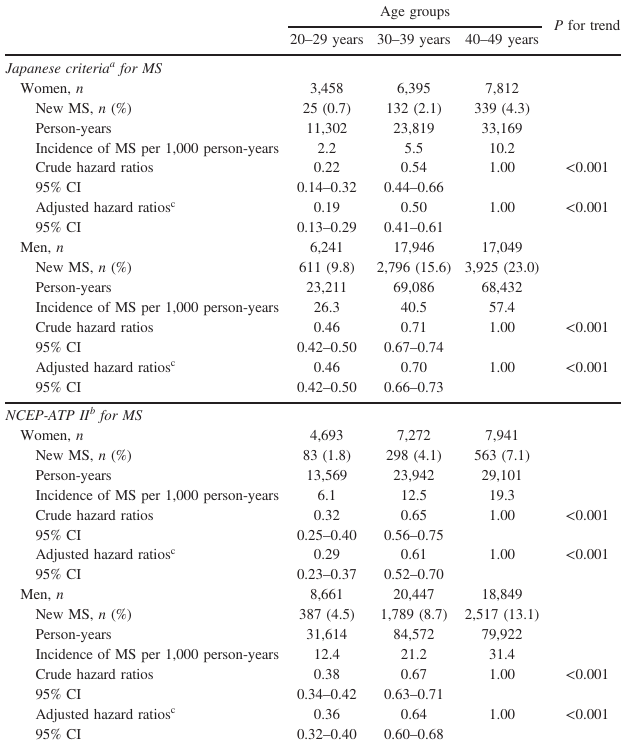
Table 4. Associations between age groups without any compo- nent of MS and new MS during 6-year follow-up Age